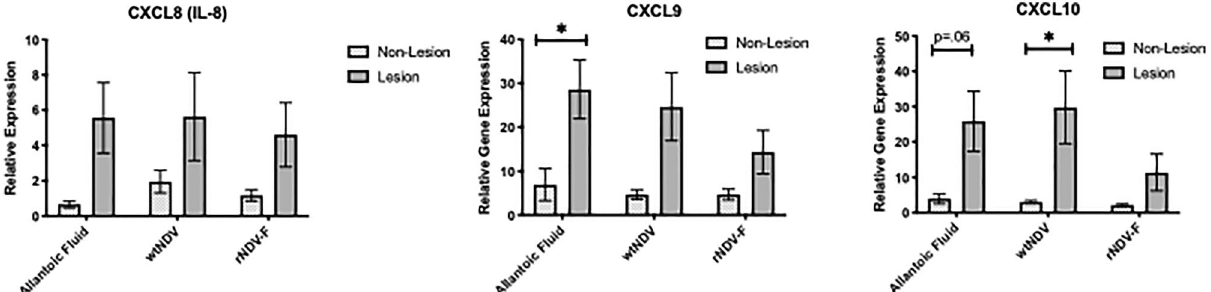
Figure 7. CXC chemokine gene expression in lung tissues of colostrum-deprived calves following BRSV experimental infection. Treatment groups of calves included: unvaccinated, uninfected controls (n = 5); intranasal (i.n.) allantoic fluid vaccinated (mock vaccine control) and BRSV challenged (n = 6); i.n. wtNDV- vaccinated and BRSV challenged (n = 5); i.n. rNDV-BRSV F opt vaccinated and BRSV challenged (n = 6). Samples from lesioned and non-lesioned portions of lung were collected from calves 7 post-challenge with BRSV and placed in RNALater. The amount of each target gene was determined by quantitative real-time PCR with normalization to RPS9. Relative gene expression of each target was determined using the 2 -ΔΔCt method. ΔΔCt values ± SE were transformed (2 -ΔΔCt ) and data are presented as the target gene expression relative to control lung samples (n = 4). Statistical analysis was performed using ANOVA. * p < .05, ** p <